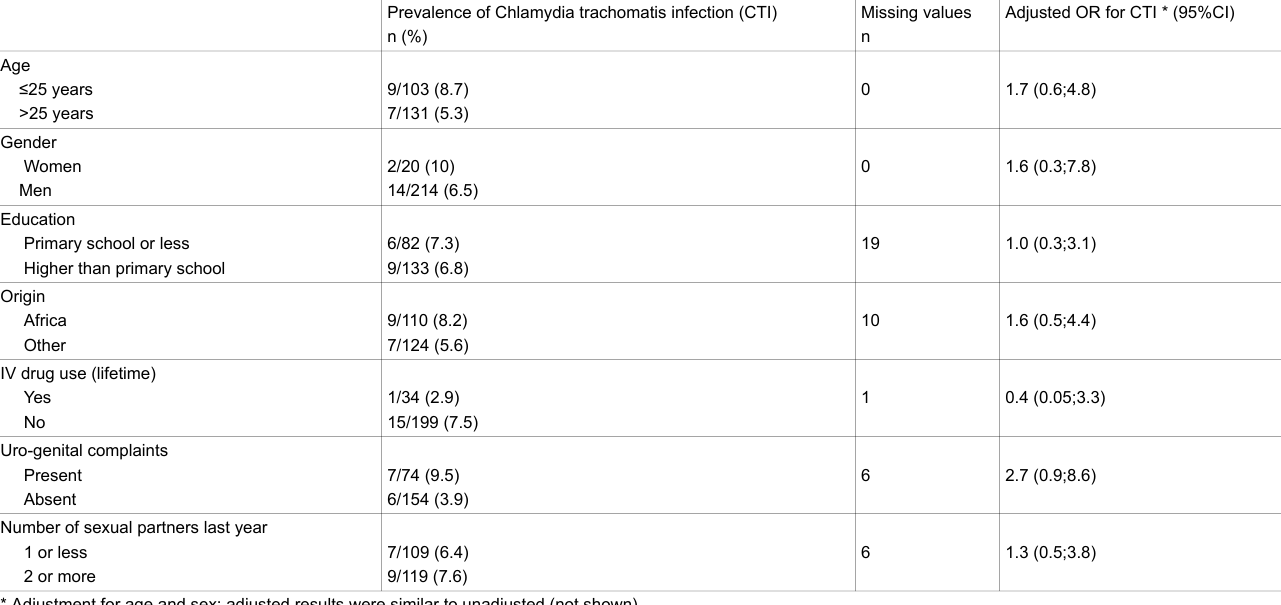
Table 1: Frequencies of potential risk factors and unadjusted and adjusted odds ratios (OR) of Chlamydia trachomatis infection (CTI) in a prison setting, Geneva, Switzerland, 2008. Prevalence of Chlamydia trachomatis infection (CTI) n